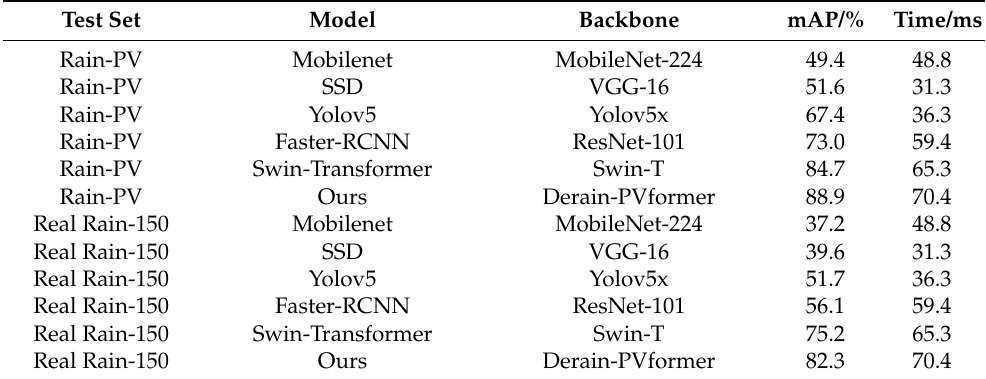
Table 2. The comparison results of performance of the different detection algorithms.